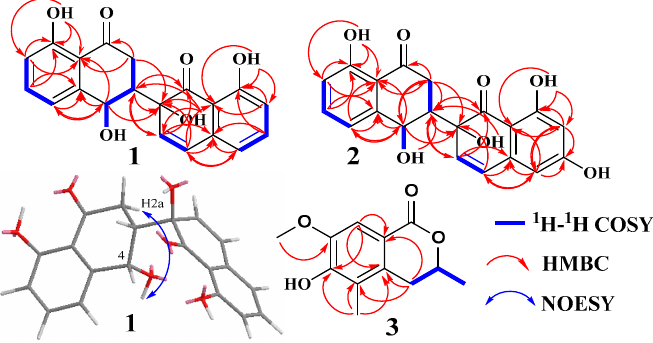
Figure 4. Key COSY, Key NOSEY, and HMBC correlations of compounds 1 – 3 .